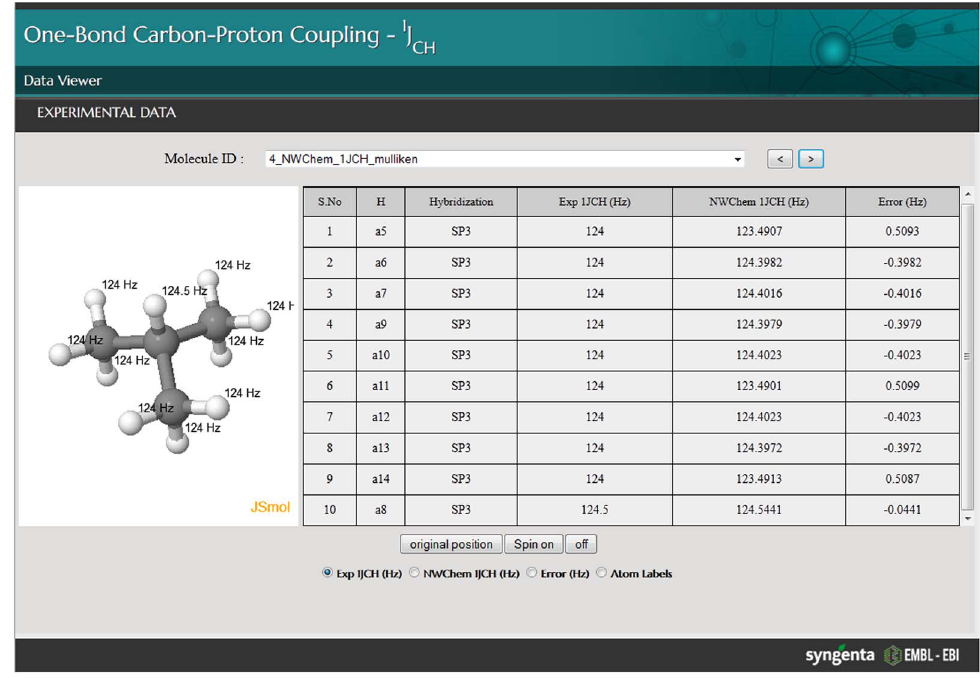
Figure 2. Screenshot of the Javascript application developed to visualise experimental and calculated 1 J CH .